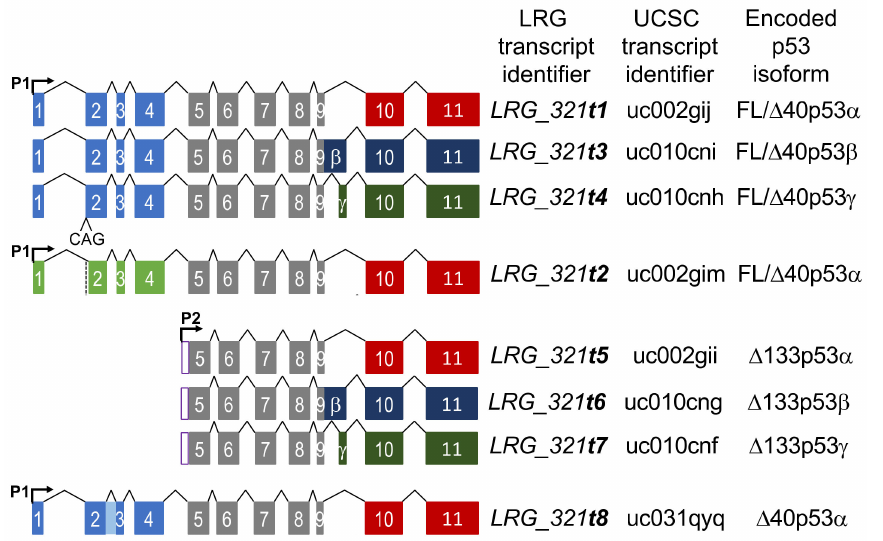
Figure 1. Schematic showing the structure of the eight TP53 reference transcripts. The Locus Reference Genome (LRG) transcript identifier, the UCSC transcript identifier and the predicted encoded p53 isoforms are also shown for each TP53 transcript. P1 and P2 refer to the P1 and P2 promoters, respectively. The light blue and light green boxes refer to transcripts with or without an additional CAG at the beginning of exon 2, respectively. The shaded light blue box between exons 2 and 3 is retention of intron 2 within the ∆ 40p53-encoding transcript, t8 . The grey boxes indicate the exons common to all transcripts. The red, dark blue and dark green boxes refer to transcripts encoding α , β and γ C-terminal